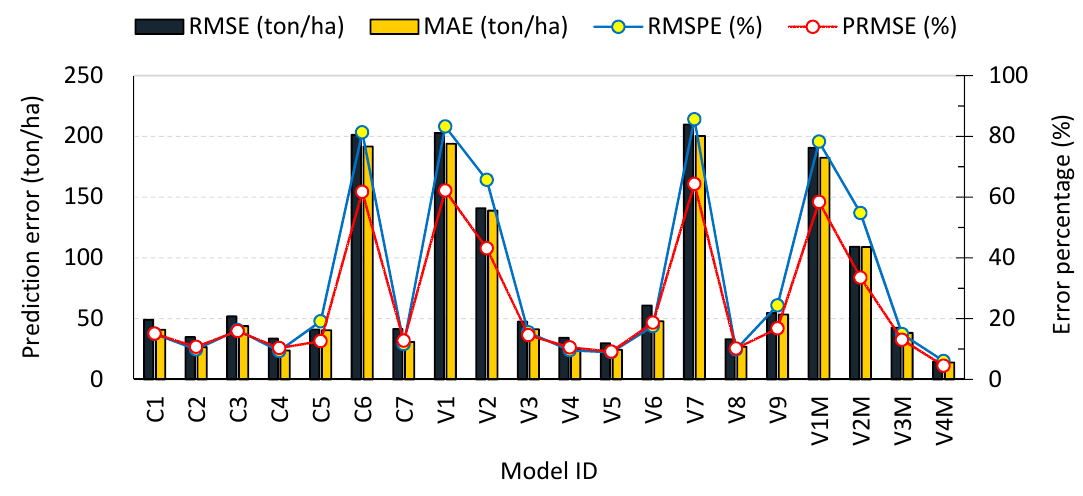
Figure 4. Prediction error variations of the tree-level AGC models in predicting stand-level AGC stocks.